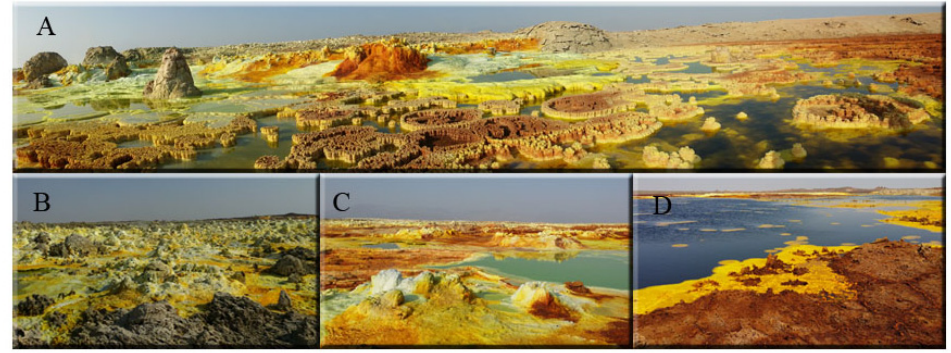
Figure 1. Geothermal Dallol area. ( A ), general view of the area. ( B , C ), Yellow and Grayish fumaroles. ( D ), Iron Black Pool.